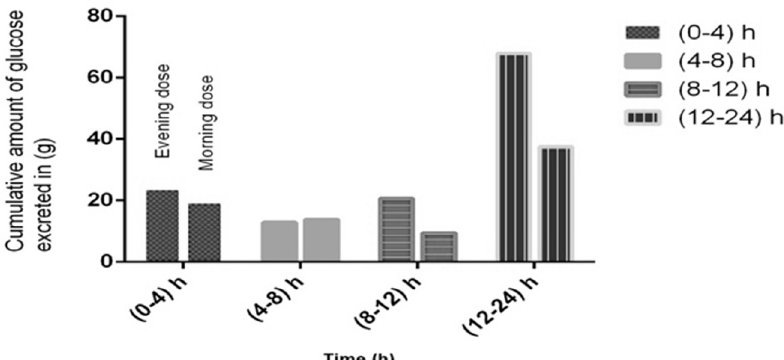
Figure 3. Cumulative amount of glucose excreted over the 24 h for phase 1 and phase 2 after administration of single oral dose of empagliflozin 10